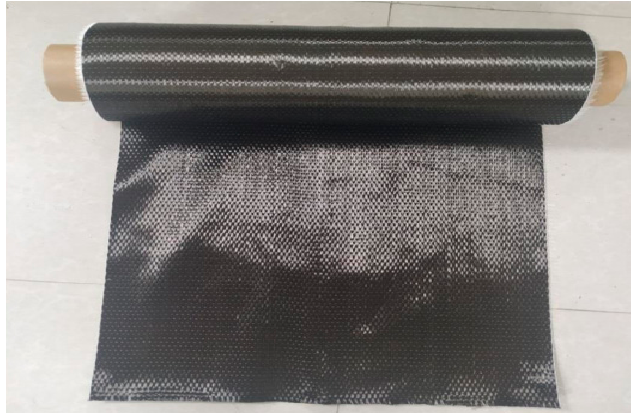
Figure 5. CFRP sheets (Sika wrap-230C).